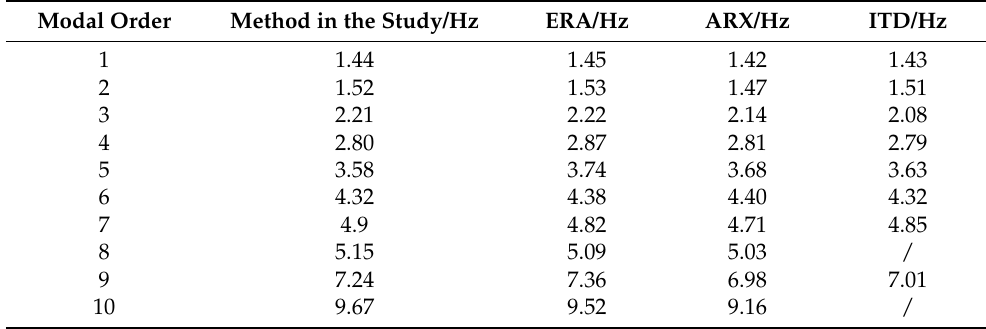
Table 3. Modal frequency identification of the high arch dam discharge structure with different methods. Modal Order Method in the